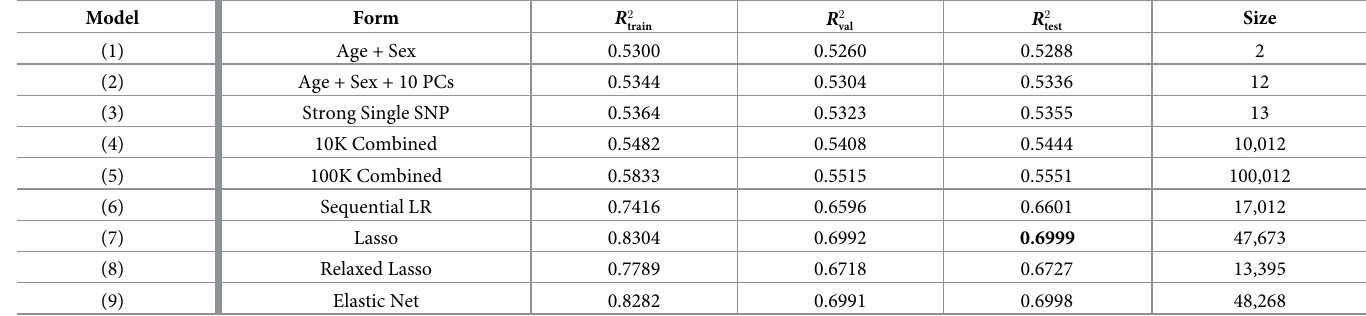
Table 1. R 2 values for height (without refitting). For sequential LR, lasso and relaxed lasso, the chosen model is based on maximum R 2 on the validation set. Model (3) to (9) each includes Model (2) plus their own specification as stated in the Form column. The elastic-net picks α = 0.9 based on the validation performance. Model